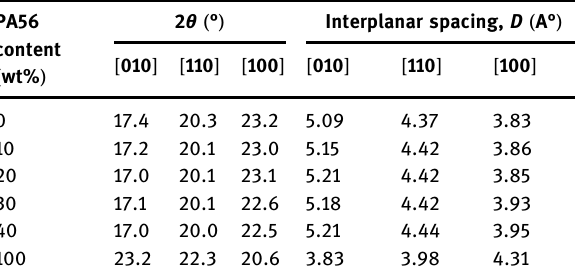
Table 5: XRD analysis data of bio - based PA56/PET blends PA56 2 θ ( ° ) Interplanar spacing, D ( A° content ( wt% )